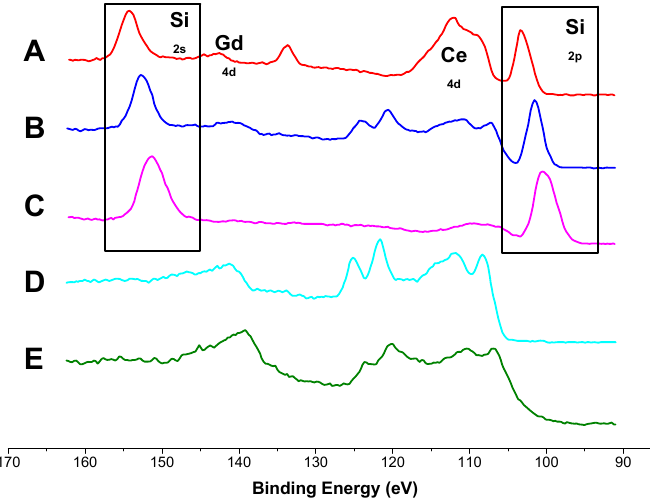
Figure 5. XPS spectra of the surface species of different GDC 10 samples treated at 750 °C in 2.5% vol H 2 in Ar with a hydrogen to water ratio of 1:1 with intermediate exposure to a maximum of 10 ppm H 2 S. A : model-composite microelectrode asymmetrically heated for 150 h; B : model-composite microelectrode symmetrically heated for 51 days; C : model-composite microelectrode asymmetrically heated for 140 h; D : Pristine model-composite microelectrode after PLD preparation; E : Macroscopic GDC polycrystal. The boxes highlights signals associated with Si surface species, the rest of the peaks can be attributed to Ce or Gd.